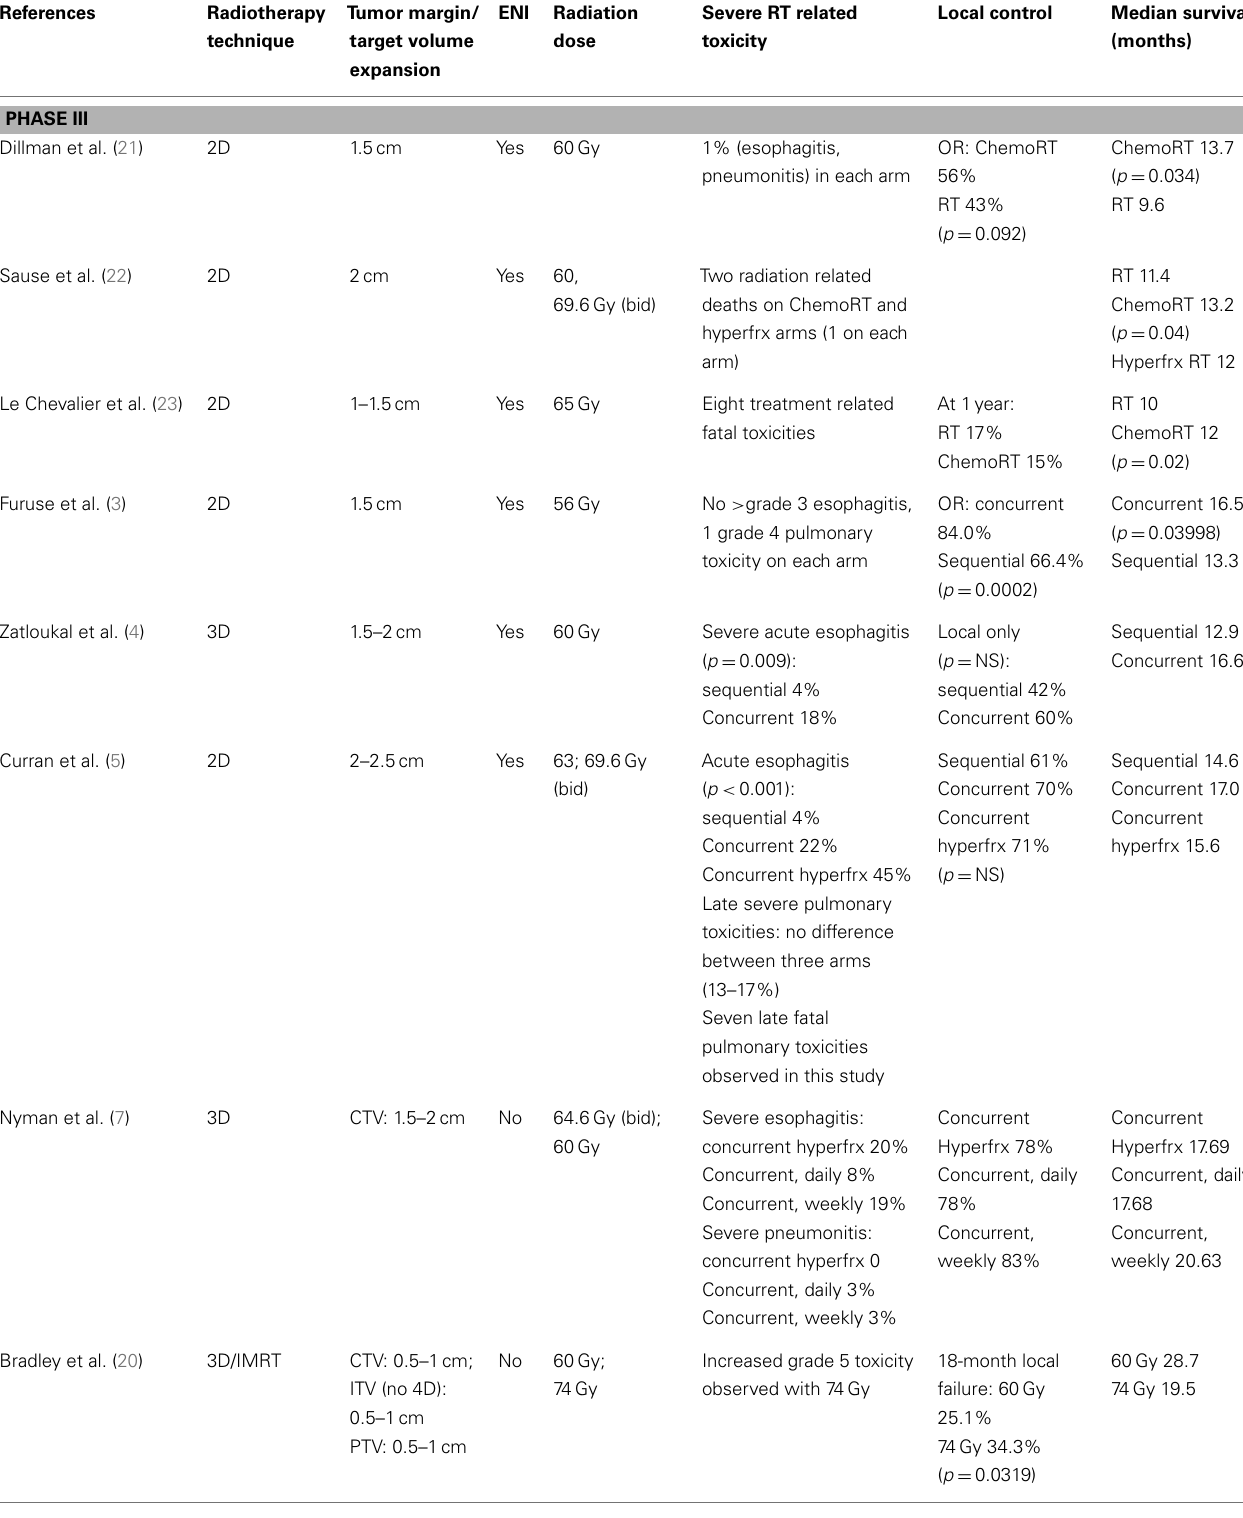
Table 1 |Target volume, toxicity, and clinical outcome in selected phase III randomized trials and phase I/II dose escalation trials combining chemotherapy and radiation for locally advanced NSCLC